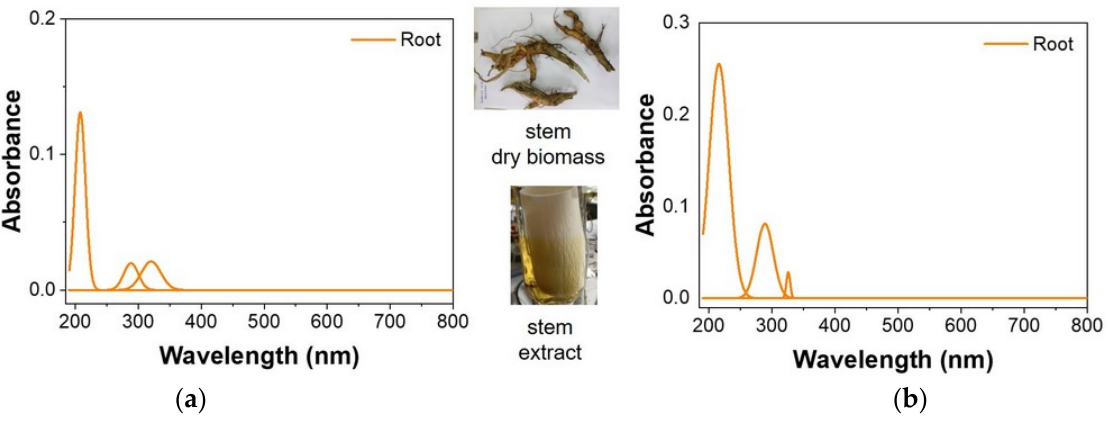
Figure 10. UV–VIS profile absorption spectra after deconvolution for Datura innoxia root matrix in ethanol extract ( a ) and 1-butanol extract ( b ).